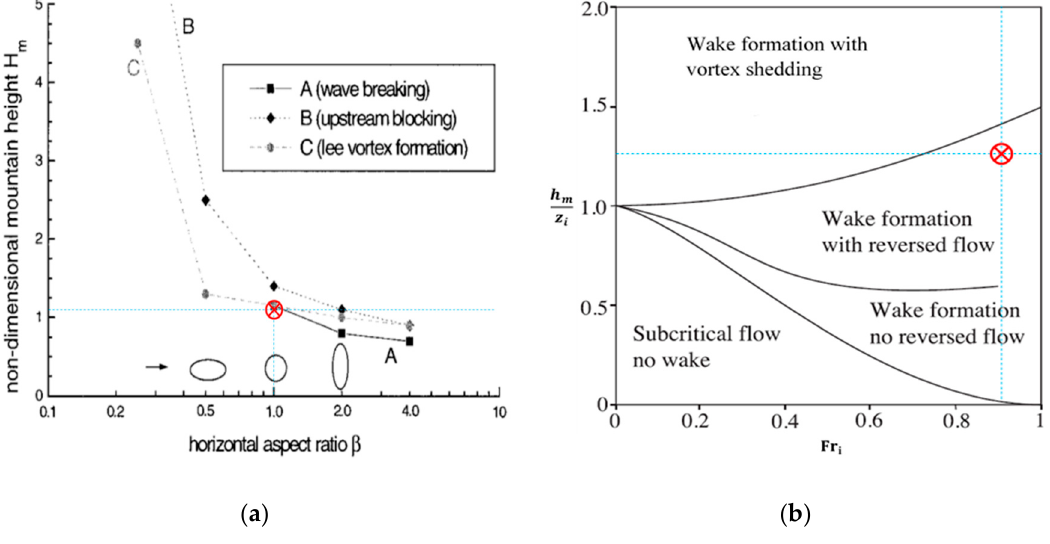
Flight 2, Figure S7: AROME turbulence indicators vs. the wind shear intensity factor I along the flight path during Flight 2. Figure S8: Variation of Turbulent Kinetic Energy (TKE) and Eddy Dissipation Rate (EDR) with Height for (a): Flight 1 and (b) Flight 2. Figure S9: Turbulence Intensity for both Flights. Figure S10: Absolute Value Wind Direction Errors versus Wind Speed for both Flights.